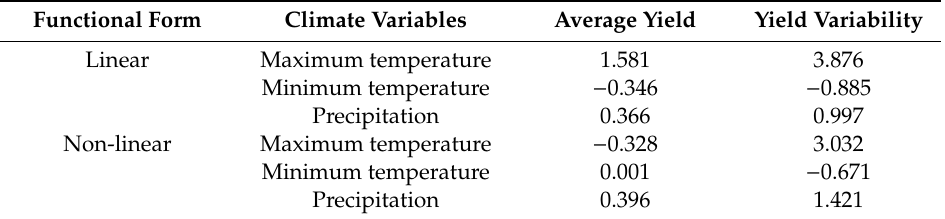
Table 8. Elasticities of climate variables for the linear and non-linear